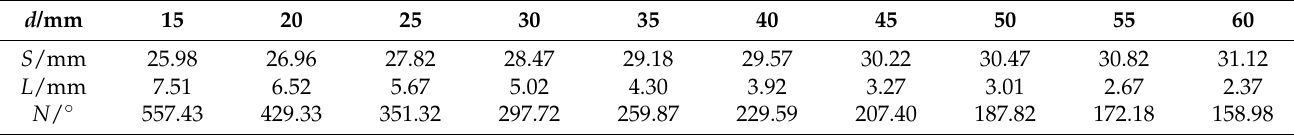
Table 2. Corresponding long claw toe internal fissures and envelope angles.